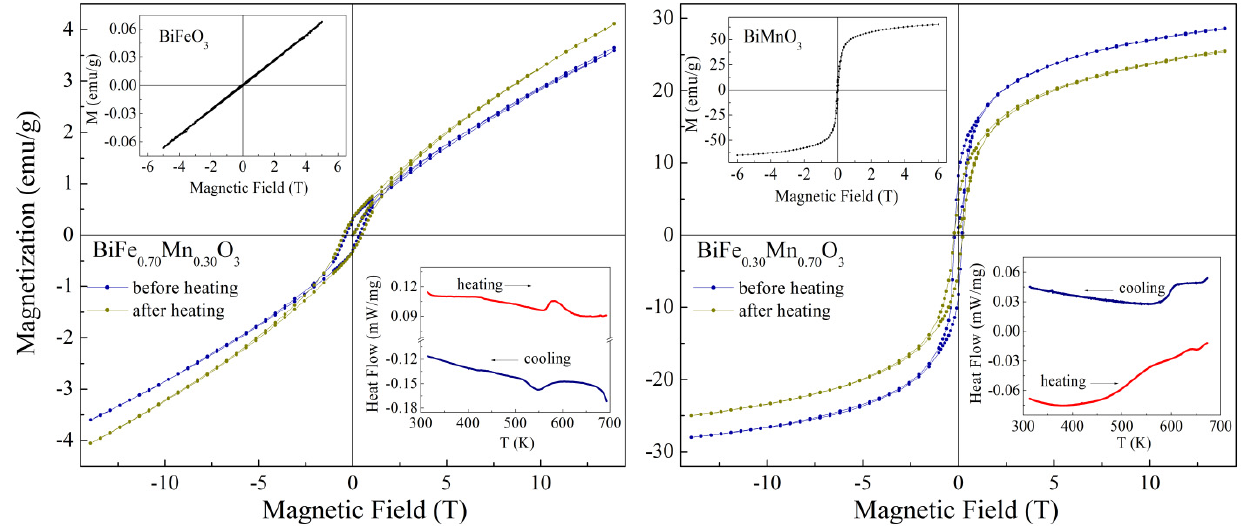
Figure 4. Isothermal-dependent magnetization curves of the compounds BiFe 1 − x Mn x O 3 (x = 0.3, 0.7) recorded at temperature T = 5 K before and after annealing at T ~ 700 K. The insets show DSC curves of the compounds and field dependence of magnetization recorded at T = 5 K for the extreme compounds BiFeO 3 and BiMnO 3 .